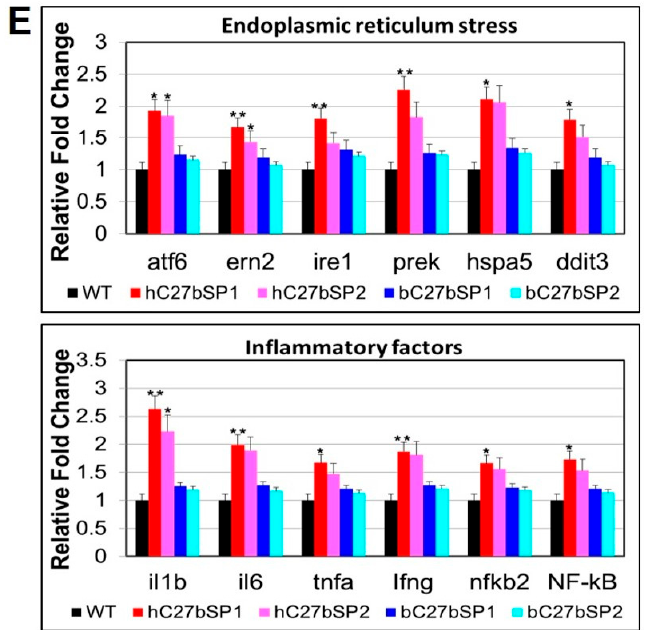
Figure 5. NAFLD and NASH phenotypes observed in hC27bSPs and bC27bSPs adults. ( A ) Liver histological changes of C27bSPs larvae at different quantities of feeding and lipid contents. The ORO staining in the liver of C27bSPs larvae fed with low-fat diet (LFD) for WT (panel 1), hC7aSPs (panels 2 and 3) and bC7aSPs (panels 4 and 5). 110X magnification, scale bars: 100 µm. The histological changes in the liver of zebrafish larvae fed with LFD for WT (panel 6), hC7aSPs (panels 7 and 8), and bC7aSPs (panels 9 and 10), 400× magnification, scale bars: 10 µm. Representative gross anatomy of the liver of 4-month-old WT (panel 11), hC7aSPs (panels 12 and 13) and bC7aSPs (panels 14 and 15) adults. 40× magnification, scale bars: 50 mm. Lipid accumulation was confirmed through ORO-stained sections from adult WT (panel 16), hC7aSPs (panels 17 and 18) and bC7aSPs (panels 19 and 20). 400× magnification, scale bars: 25 µm. ( B ) Comparison of lipid contents (liver and serum triglycerides and cholesterol) in the 11-month-old hC27bSPs and bC27bSPs adults. ( n = 4–6 for each groups). * p < 0.01, and ** p < 0.005. ( C ) Representative gross anatomy images of the 11-month-old WT (panel 1), hC27bSP1 (panel 3) and hC27bSP2 (panel 5) livers. 40× magnification, scale bars: 50 mm. H&E staining of the 11-month-old WT (panel 2), hC7aSP1 (panel 4) and hC7aSP2 (panel 6) livers, demonstrating induced liver stress and damage in hC27bSPs compared with WT at the same stage. 400× magnification, scale bars: 50 µm. ( D ) Levels of hepatic MDA, and H 2 O 2 in hepatic mitochondria was compared with hC27bSPs, bC27bSPs, and WT adults fed a LFD for four weeks. ( E ) Expression of endoplasmic reticulum (ER) stress markers, atf6, ern2 , ire1 , prek , hspa5 , grp78 , and ddit3 (up) and inflammatory genes, il-1b , il-6 , tnf- α , ifn- γ , nfkb2 , and NF-kB , is increased (down). The qRT-PCRs were performed in triplicate. Expression analysis of the selected genes using cDNA prepared from average four months male–female fish pairs per groups. Values were normalized against β -actin. The asterisk represents statistically significant differences; * p < 0 .01, and ** p < 0.005 levels as compared to control.